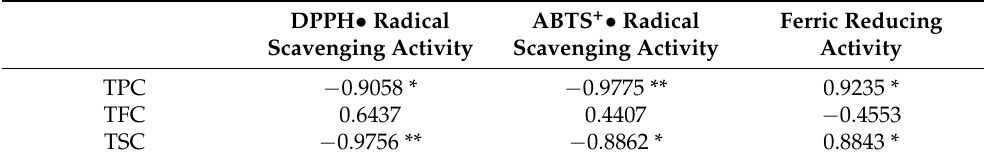
Table 3. Correlation co-efficient between antioxidant activities and TPC, TFC, and TSC in dried